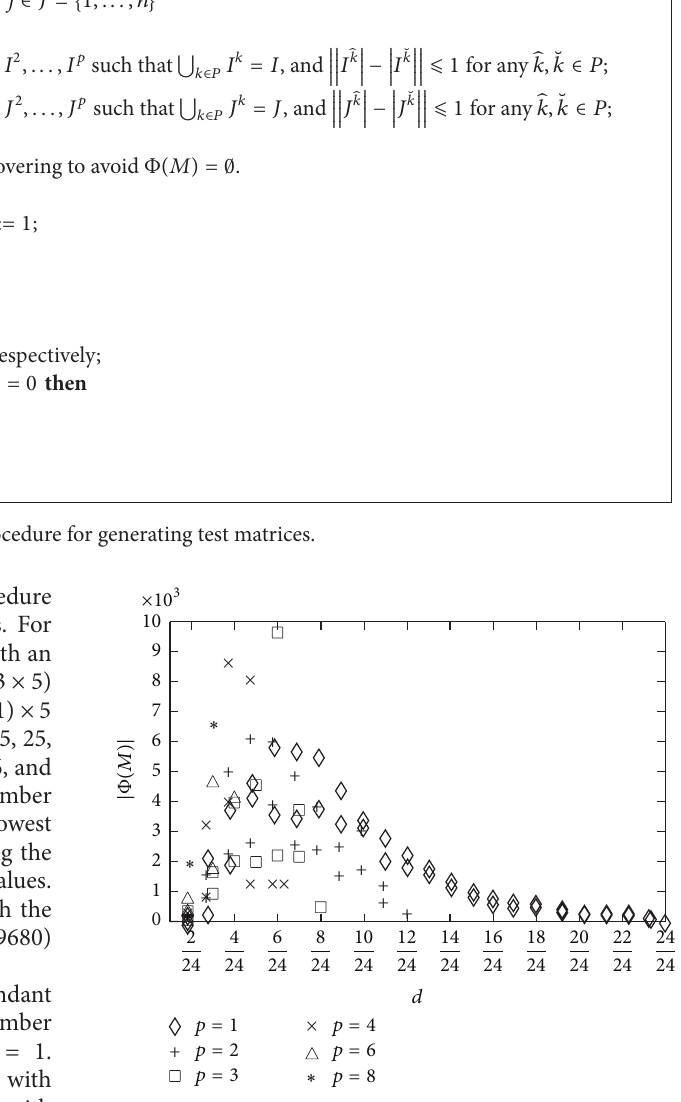
Figure 2: Density 𝑑 versus the number of irredundant coverings |Φ(𝑀)| .